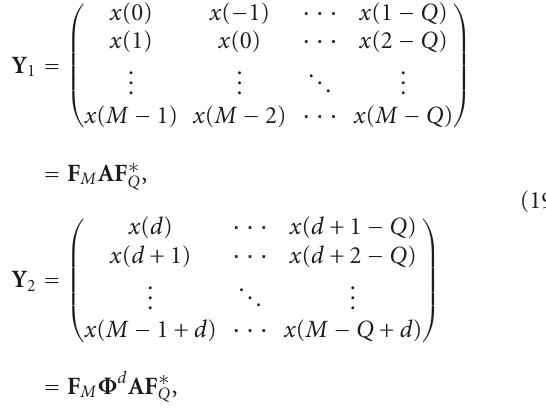
The two key factors in the derivation of (17) are that